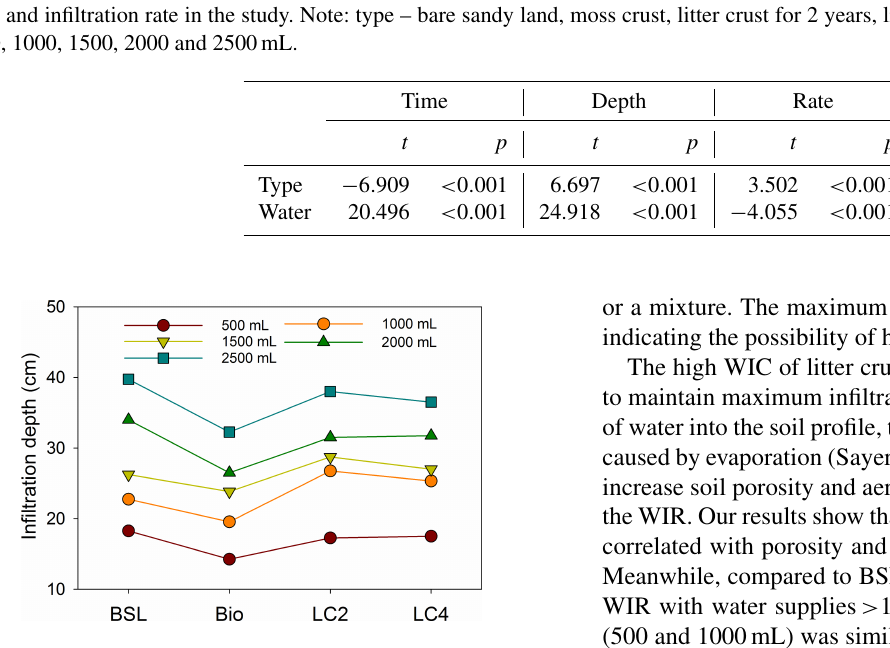
Figure 5. Water infiltration depth of different water supplies among bare sandy land and crust types. Note: BSL, bare sandy land, Bio, moss crust; LC2, litter crust for 2 years; LC4, litter crust for 4 years; 500, 1000, 1500, 2000, and 2500mL represent the quantities of wa- ter supplied at different